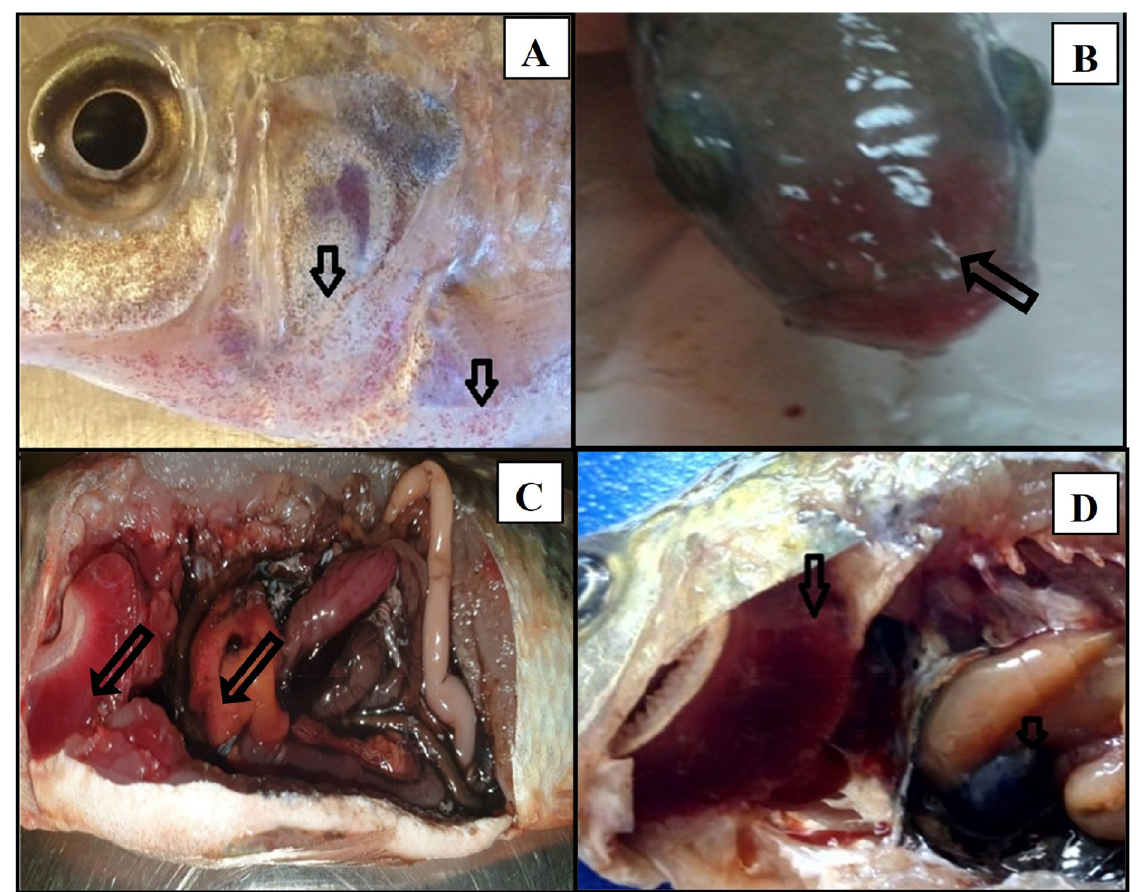
Figure 6. Symptoms in challenged Oreochromis niloticus with Aeromonas hydrophila. ( A ) petechial hemorrhage at pectoral fin and operculum in malathion in fish exposed to combined chemicals. ( B ) erythema and Redding of mouth in glyphosate exposed fish. ( C , D ) enlarged liver with congestion in gills in malathion and glyphosate exposed fish,